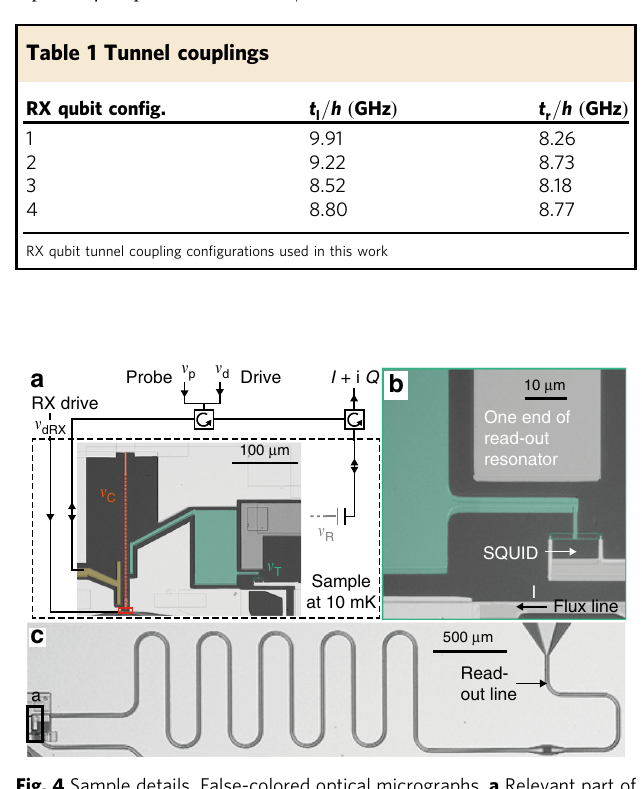
Fig. 4 Sample details. False-colored optical micrographs. a Relevant part of the sample (dashed region) false colored as follows: SQUID array (coupling) resonator in orange with corresponding drive and probe port in yellow, transmon in green, one end of the 50 Ω (read-out) resonator in gray, GaAs in black and grounded Al in white. The position of the TQD (see Fig. 1c) is outlined with a red rectangle. The microwave lines that route probe and drive tones to the sample are shown. The frequencies ν i are labeled as in Fig. 1a. b Magni fi ed optical image of the transmon region in a . The positions of transmon SQUID and fl ux line with current I are